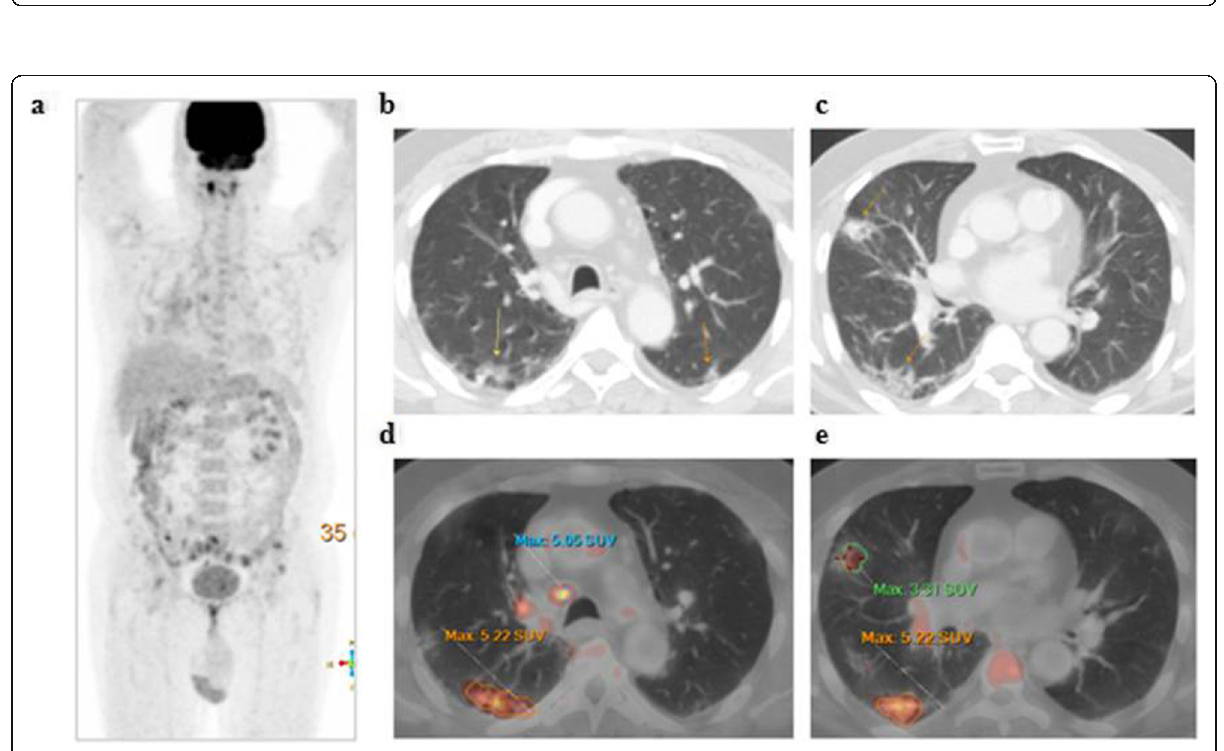
Fig. 4 A 51-year-old male patient, with a history of treated lymphoma 5 years ago, referred for follow-up PET/CT evaluation. a The whole-body MIP image shows multiple bilateral pulmonary metabolically active areas. Axial lung window CT images ( b , c ) revealed multiple bilateral subpleural variable-sized ground-glass opacities associated with septal thickening (crazy-paving pattern) that show variable FDG avidity on corresponding fused PET/CT images ( d , e ) achieving up to 7.4